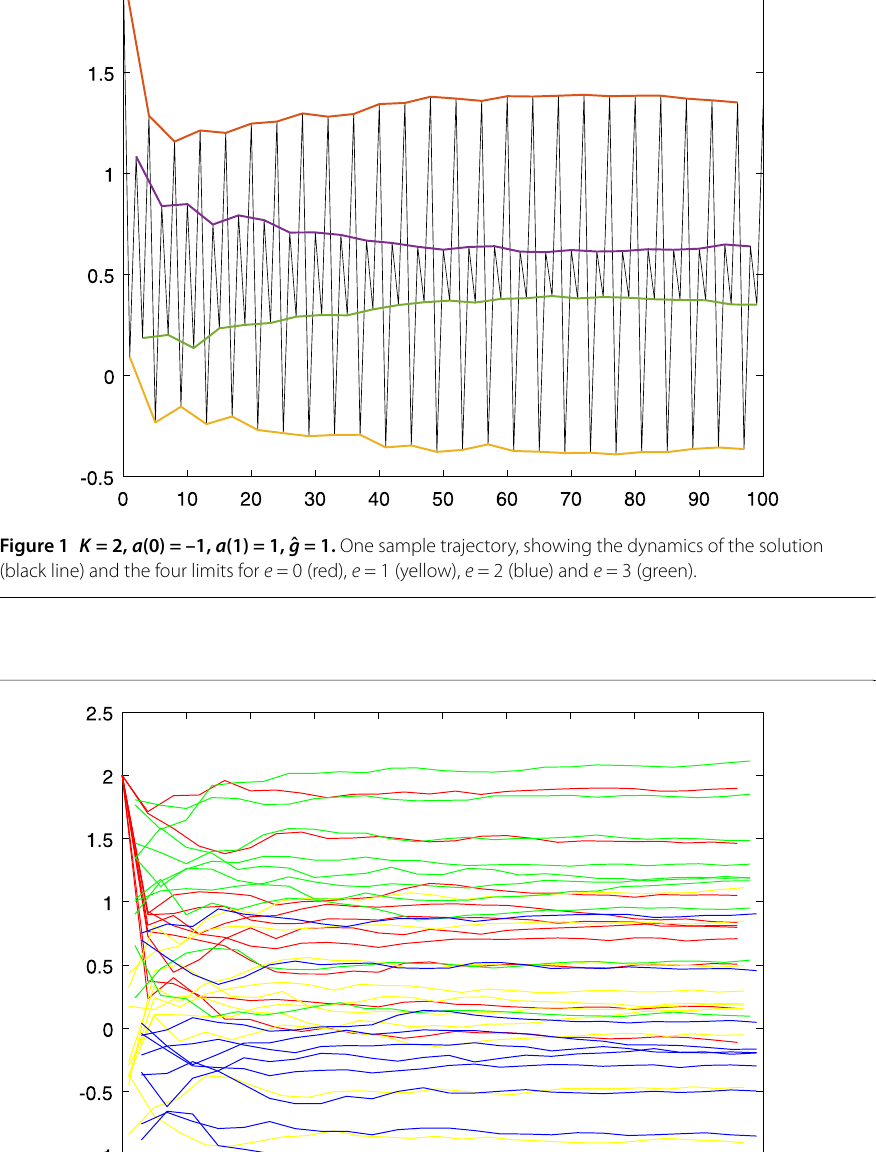
Figures  and  demonstrate two different samples of ten runs, showing the random limits for e = ,,,. Figures  and  demonstrate the random limits for e =  and e = , respectively, for  different